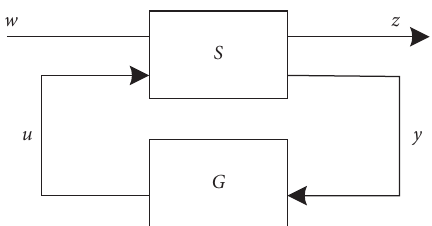
Figure 2: The diagram of standard H ∞ control